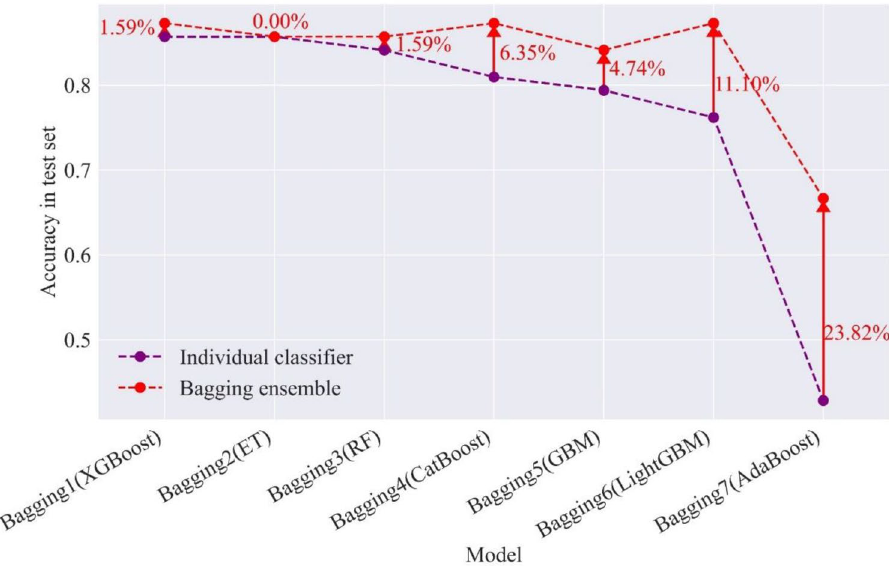
Figure 12. The accuracy improvement of bagging combination models in the test